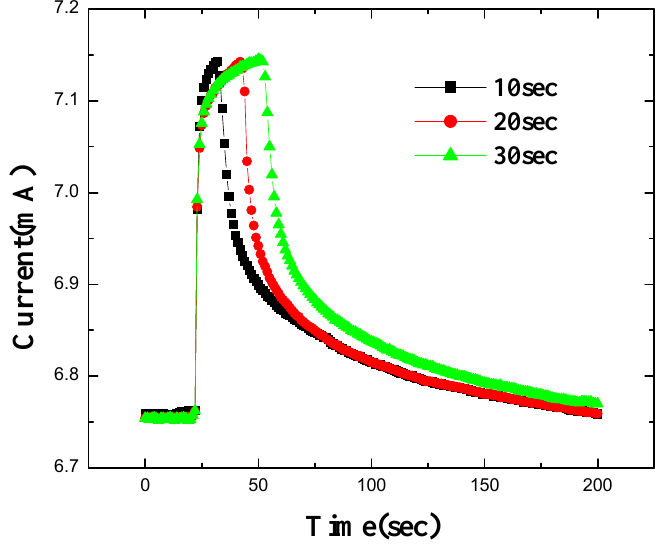
Figure 10. Time response at 25 °C of MOS-HEMT based diode forward current at a fixed bias of 2V when switching the ambient from N 30 sec and then back to pure N